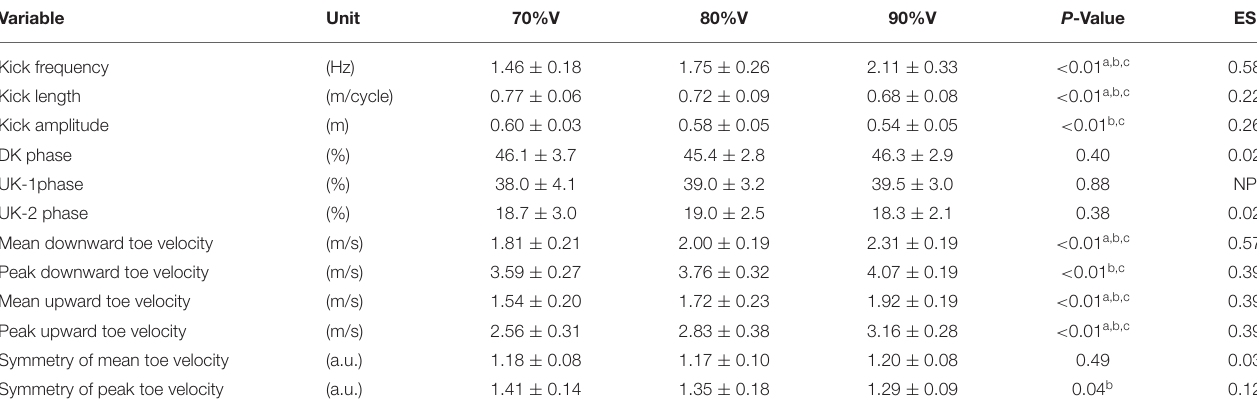
TABLE 1 | Results of kinematic variables in the 70, 80, and 90%V trials.